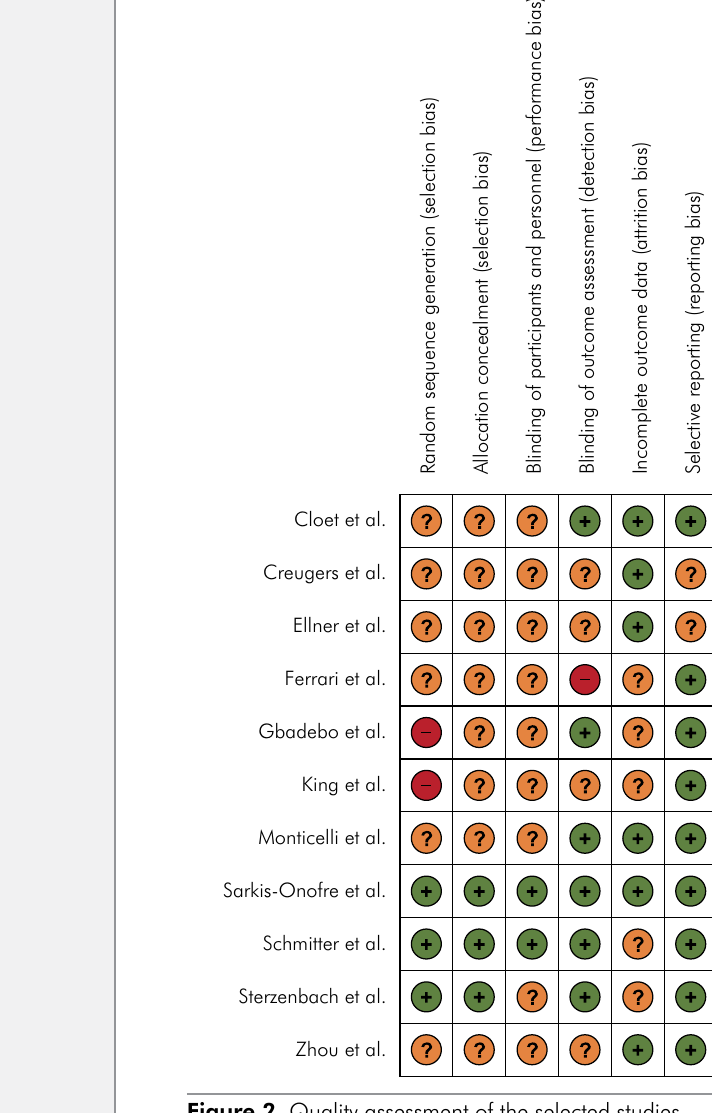
Figure 2. Quality assessment of the selected